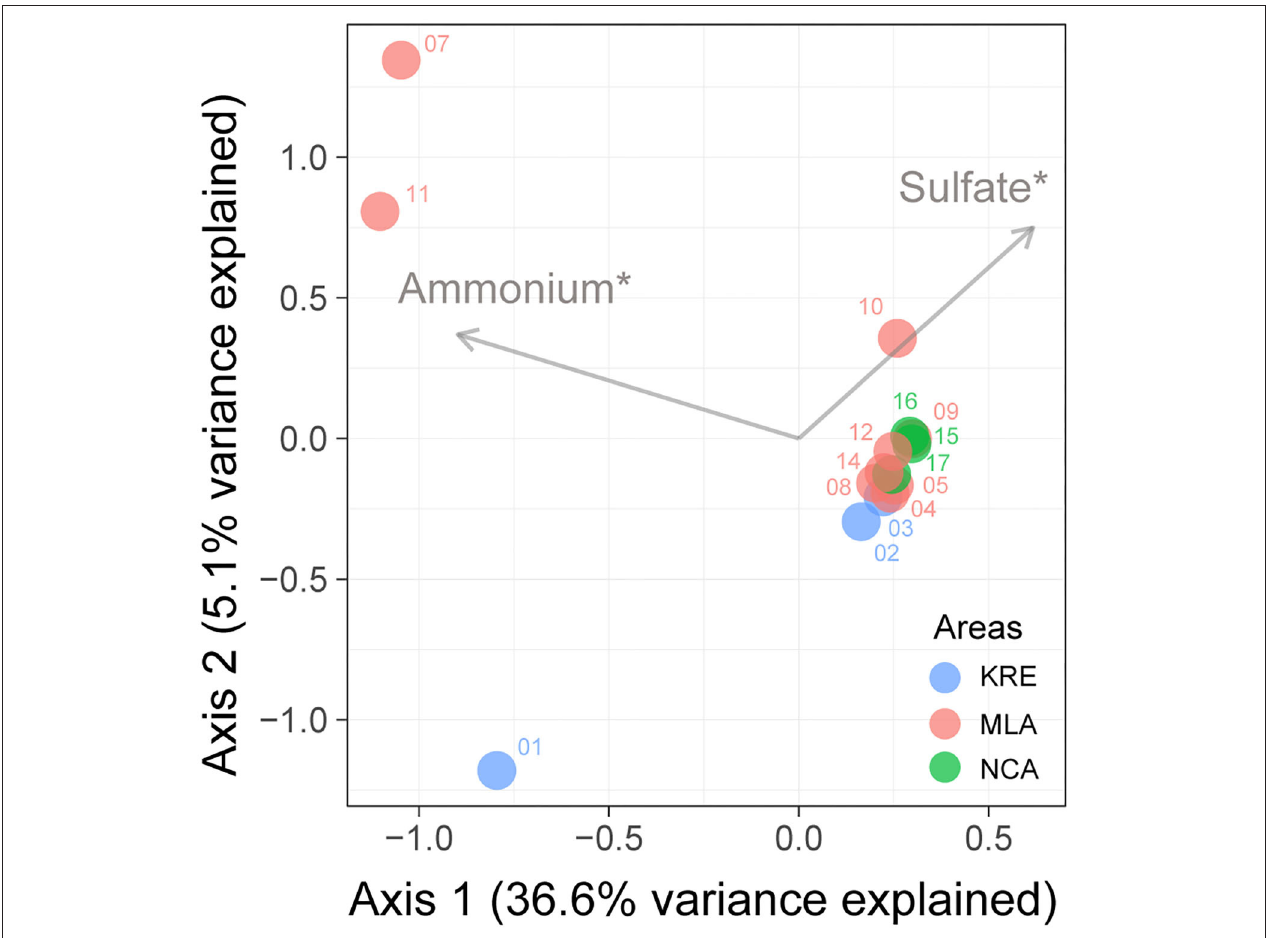
FIGURE 5 | Redundancy analyses (RDA) ordination plots showing the significant environmental factors in structuring variations in the community composition of nitrous oxide reducer in Lake Bosten. Significance levels: *corrected p -value < 0.05. KRE, Kaidu River Estuary; MLA, Main Lake Area; NCA, Northwestern Coastal